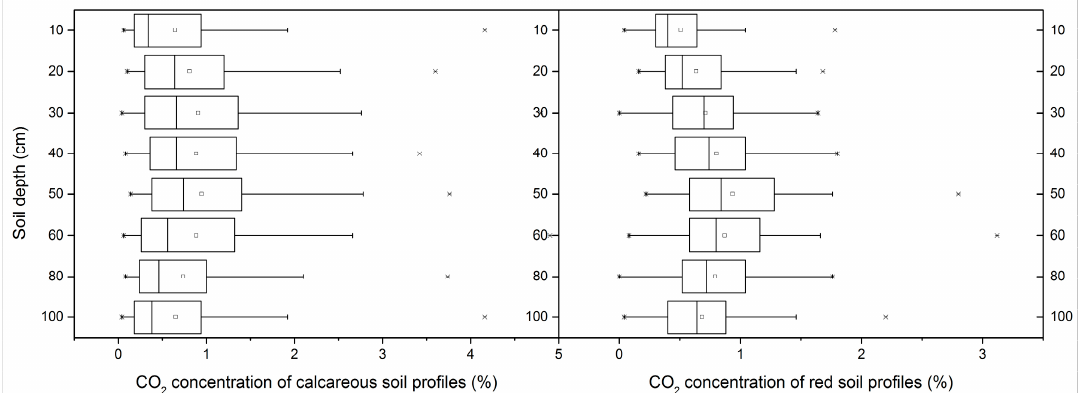
Figure 5. Summary statistics of overall mean soil CO 2 concentrations in calcareous and red soils. Open square: average; vertical line: median; box: upper and lower quartiles; horizontal lines: 1st and 99th percentiles; ×: minimum and maximum values. N = 168.